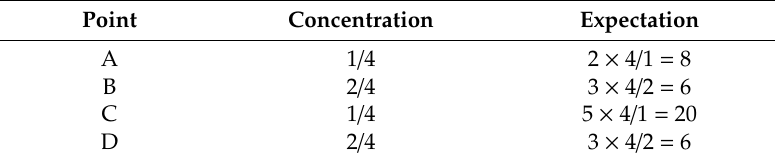
Figure 2. Example of calculating concentration and expectation. Table 1. Calculation result of concentration and expectation.